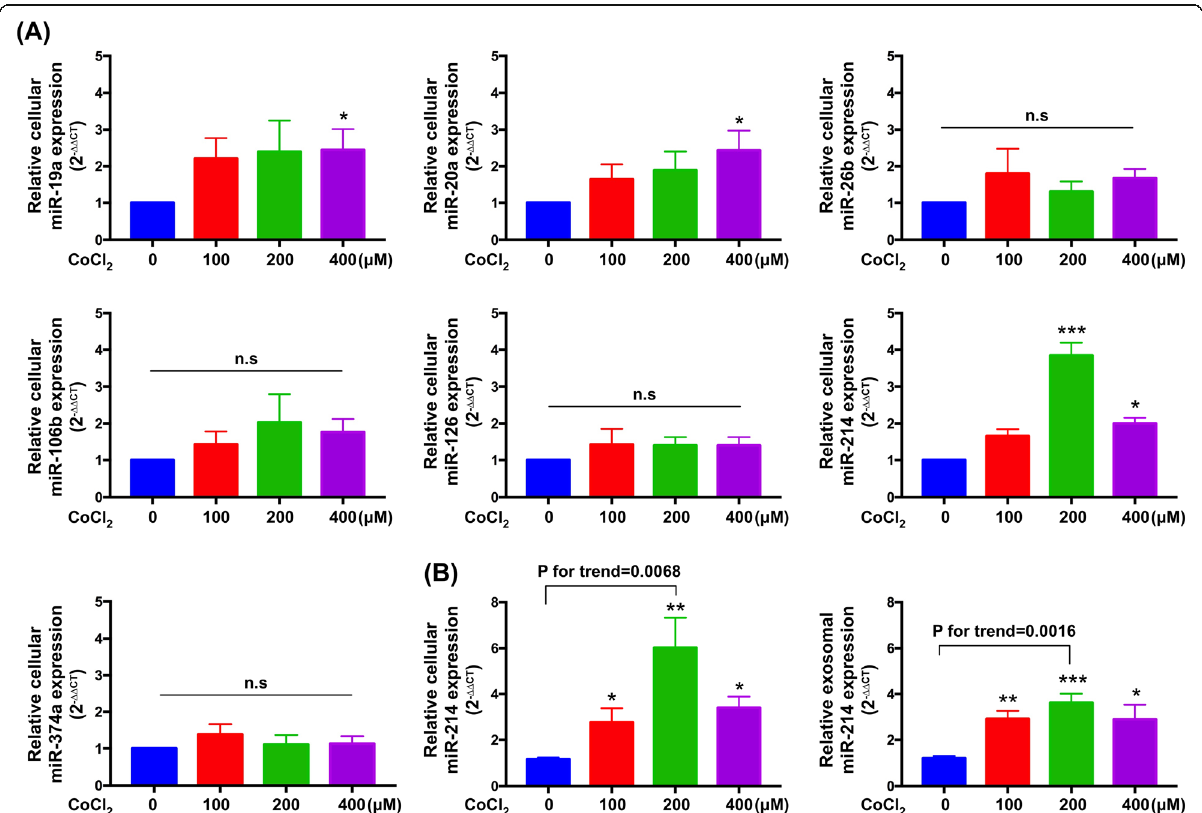
Fig. 3 Cellular and exosomal microRNA-214-3p levels (miR-214) in response to CoCl 2 . a Mean normalized expression levels of A7r5 cellular miRNAs (miR-19a, − 20a, − 26b, − 106b, − 126, − 214, and − 374) as determined by miRNA-specific SYBR Green PCR assays in response to CoCl 2 for 48 h and normalized to RNU6B. Expression values are presented relative to medium only control ( n = 6). b Total exosome isolation reagent isolated from A7r5 VSMCs after 48 h at CoC 2 were spiked with cel miR-54 and used for RNA extractions. This exosomal RNA was then assayed for miR-214 and cel miR-39 by qRT-PCR and normalized to exogenous cel miR-54 ( n = 6). Data are presented as the means ± SEM. * P < 0.05; ** P < 0.01; *** P < 0.001; ns, non-significance (one-way ANOVA with Tukey-Kramer post hoc